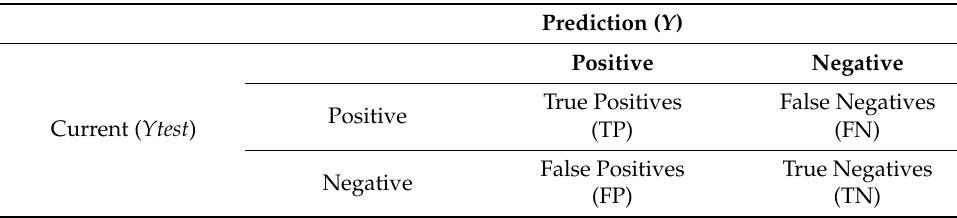
Table 2. Confusion matrix for binary